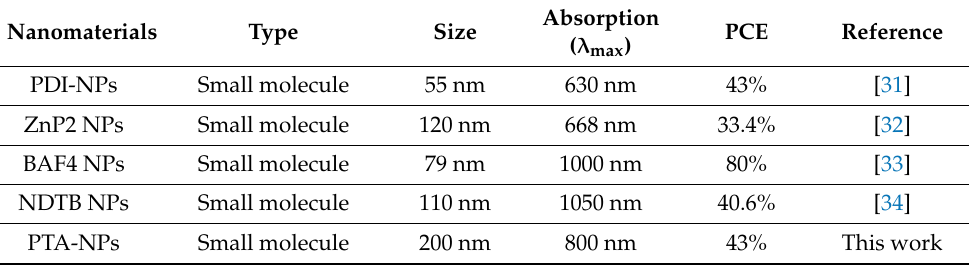
Table 1. Comparison of different organic nanomaterials for